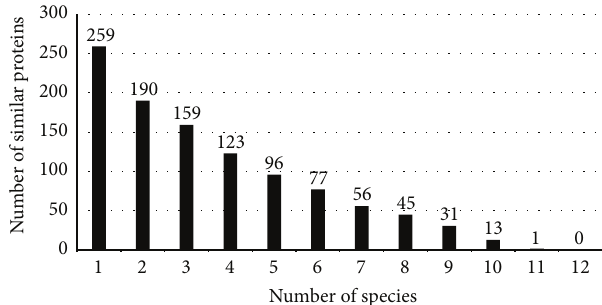
Figure 4: Bar-graph depicting the number of Dichelobacter nodosus genes that are homologous with proteins of different number of pathogenic bacterial